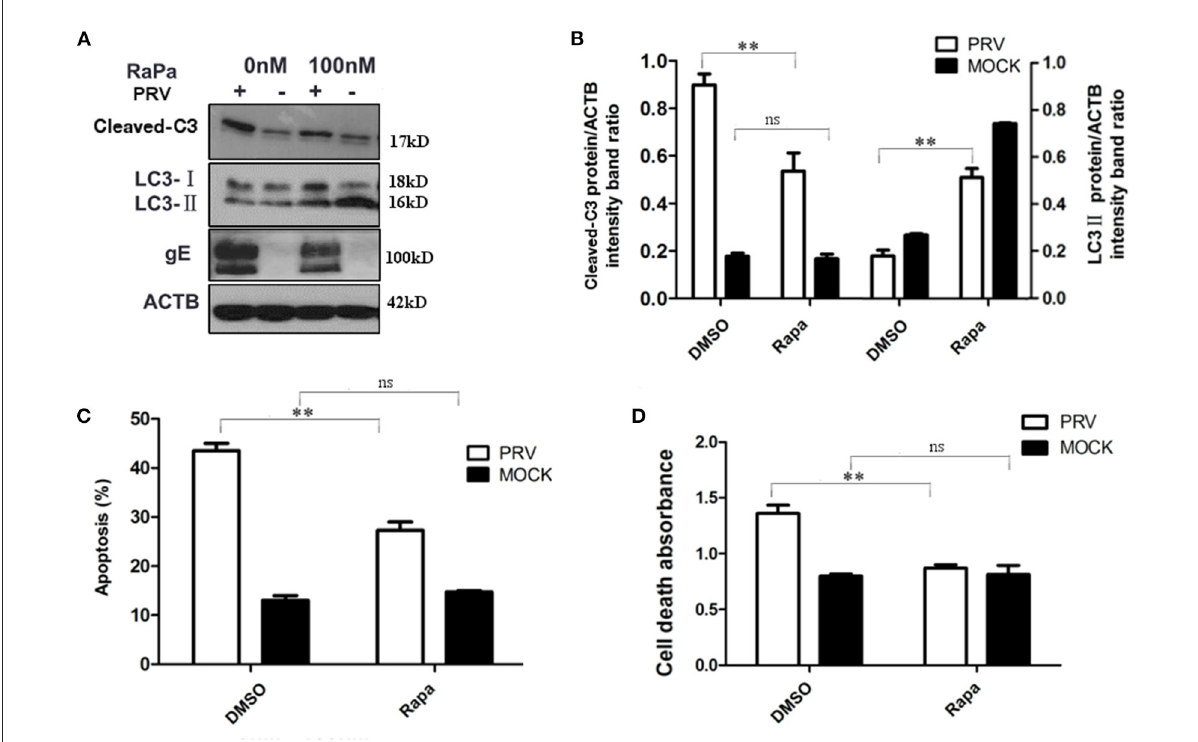
FIGURE3 The increased autophagy decreased PRV-induced apoptosis. (A) PK-15 cells were treated with rapamycin, followed by PRV infection. The cells were lysed and analyzed by Western blot, and the statistical analysis of the cleaved-caspase-3/ACTB was performed, shown in (B) . (C) The cells were treated as in (A) , and the percentage of apoptosis cells was detected by flow cytometry. (D) The cells were treated as in (A) and lysed, and cell-death ELISA was performed. All results are representative of three independent experiments. The data represent the mean ± SD of three independent experiments and are analyzed by two-way ANOVA, ** P <